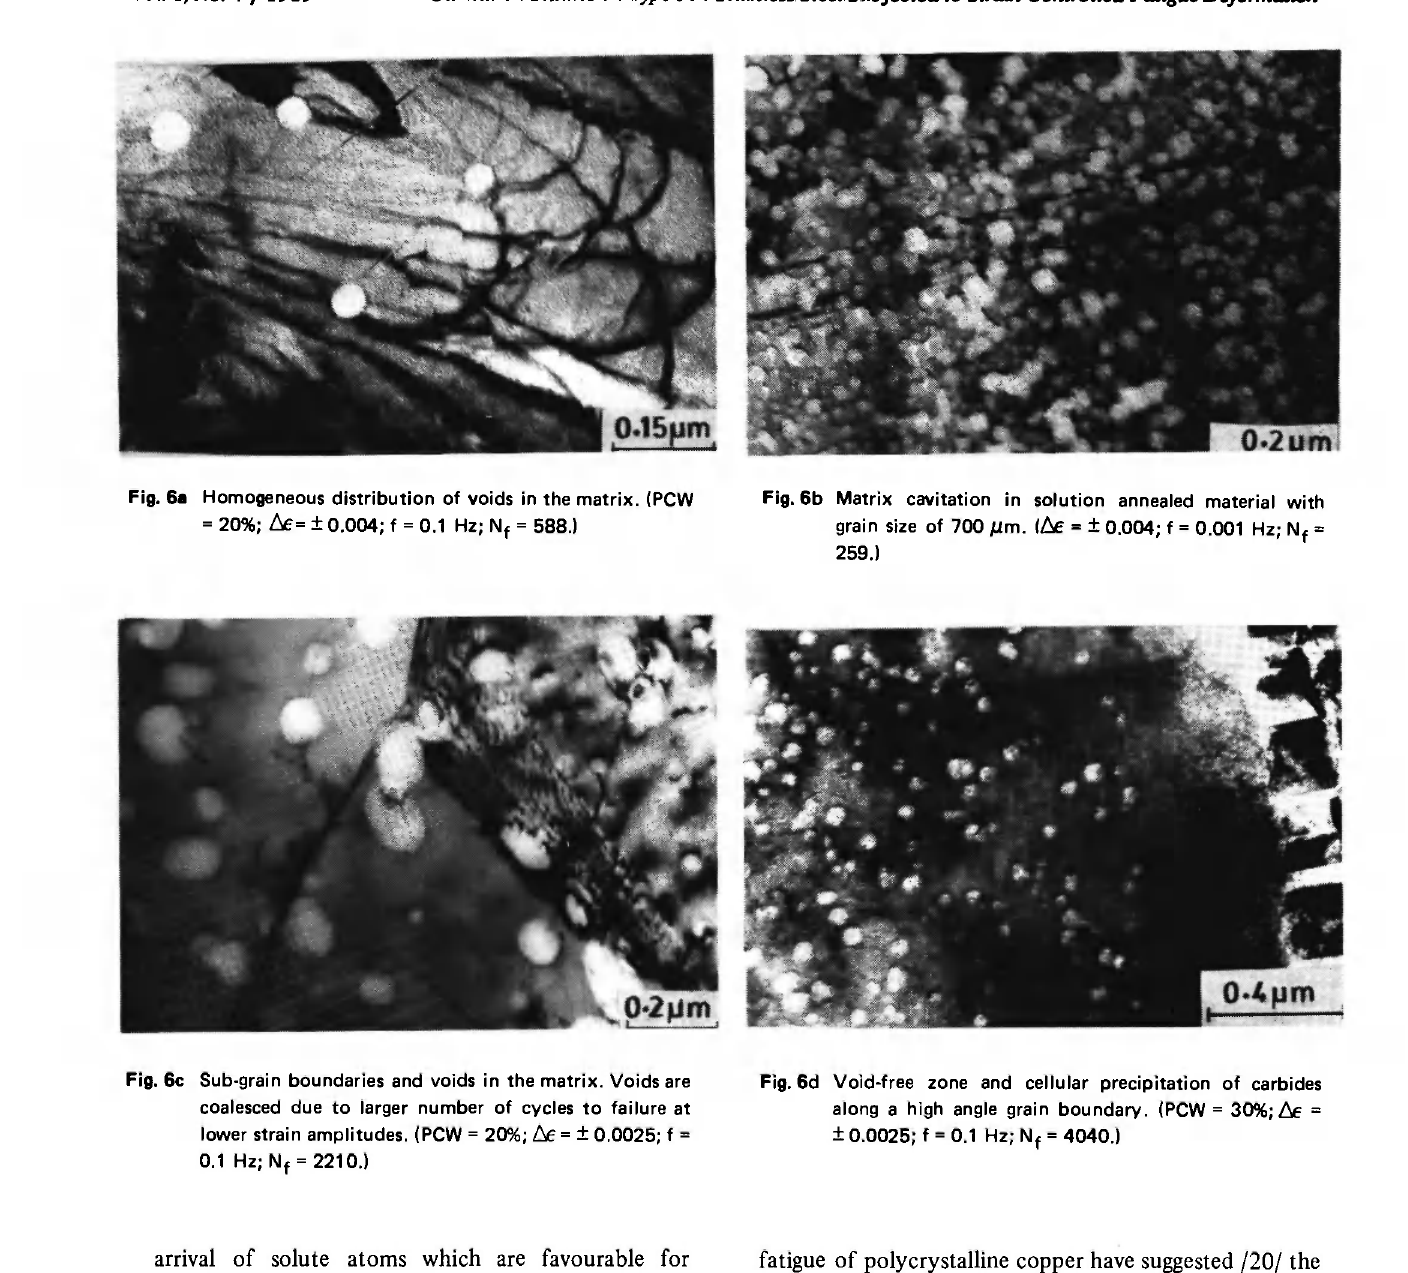
Fig. 6d Void-free zone and cellular precipitation of carbides along a high angle grain boundary. (PCW = 30%; Ae = ± 0.0025; f = 0.1 Hz; N f =